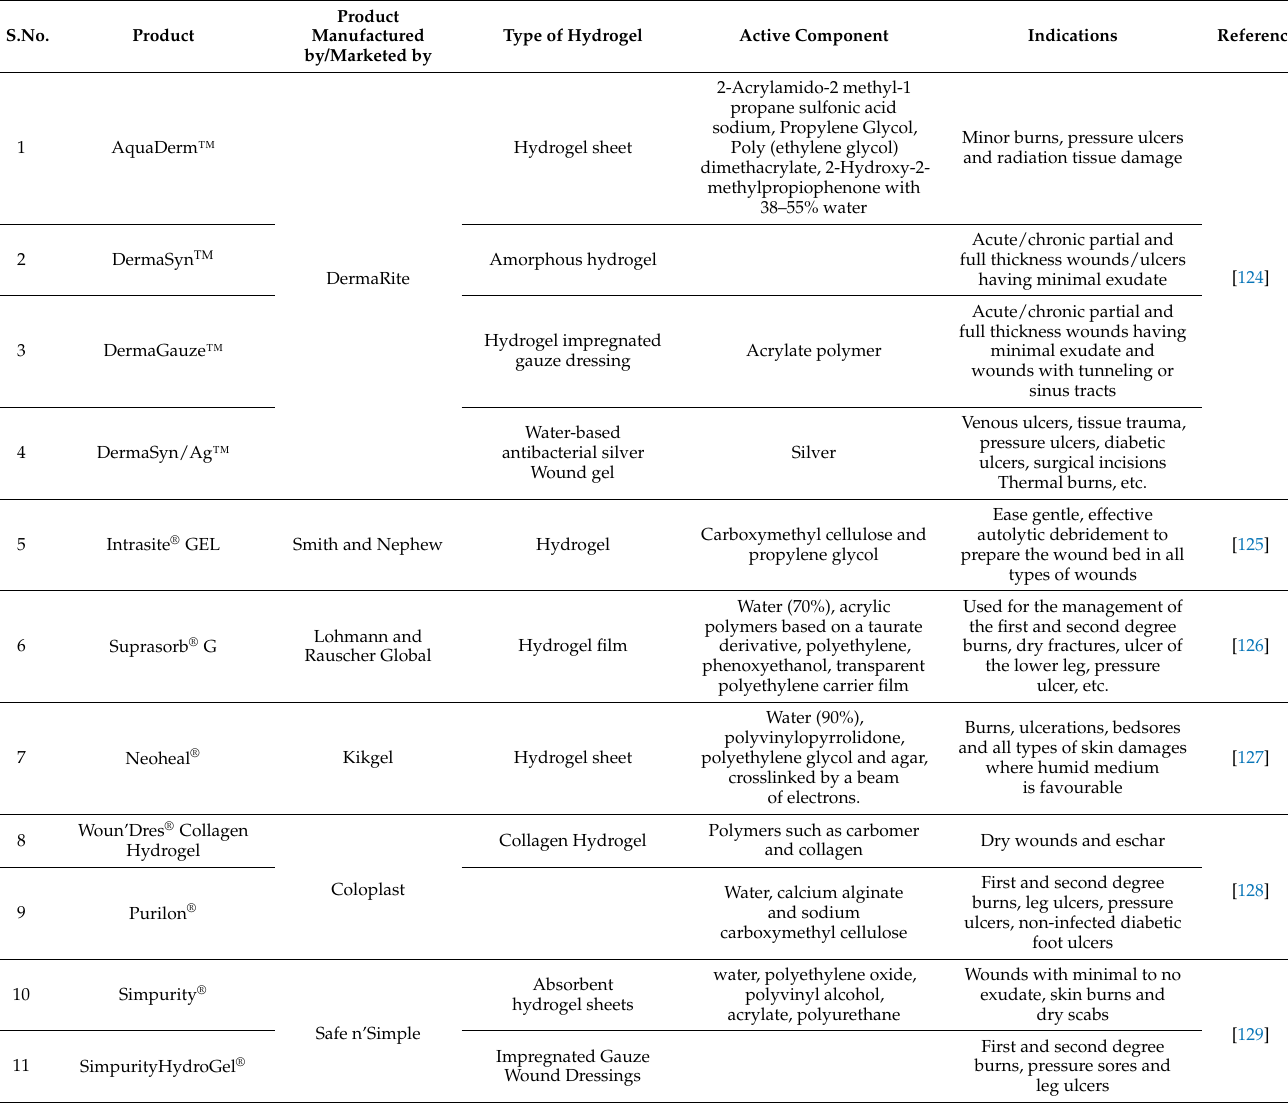
Table 5. Commercially available hydrogel